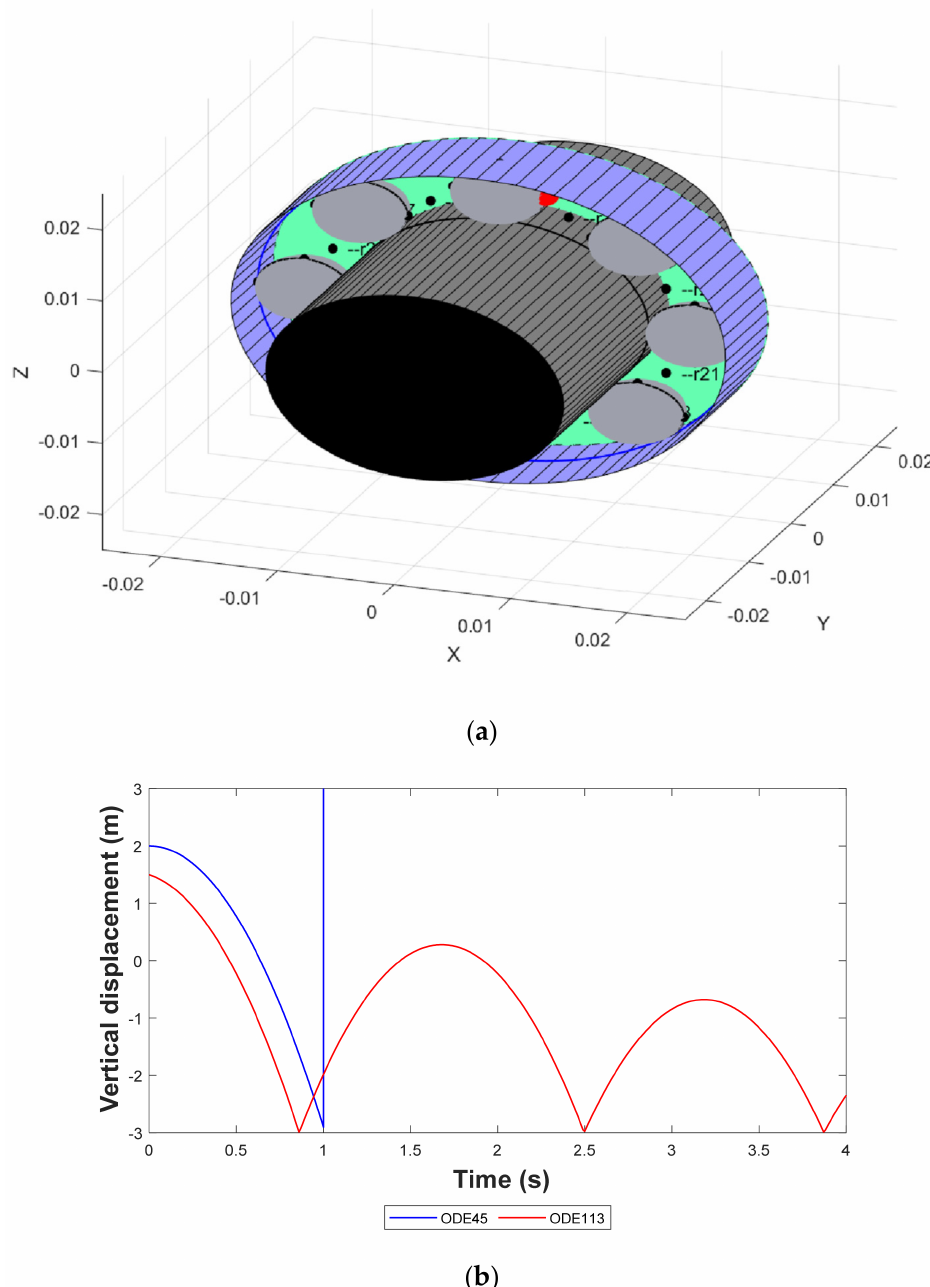
Figure 15. Practical application example of the algorithms described in Sections 3.1 and 3.2: ( a ) ar- rangement of the bodies of the bearing; ( b ) evolution of vertical displacement of one of the balls, when clearance is large enough, without considering the inner